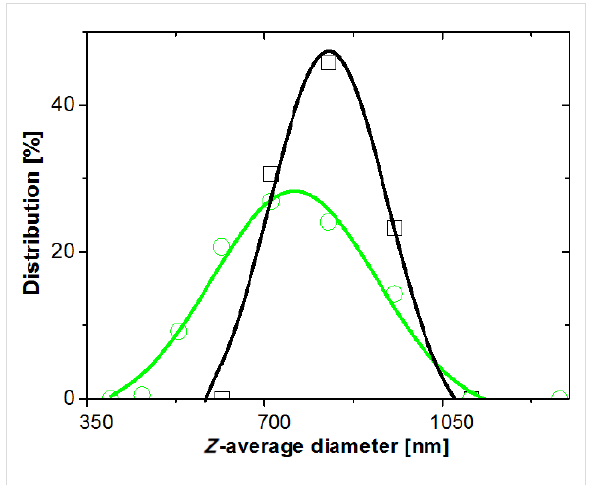
Figure 6: Size-distribution profile of BNNTs (black squares) and P(AA- co -FA)-functionalized BNNTs (green circles) in water. The concentra- tion in the distilled water was 1